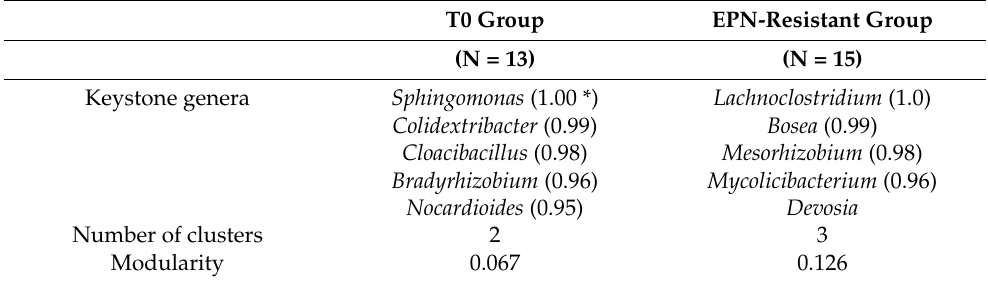
Table 3. Basic characteristics of microbiome networks in the T0 group of A. solstitiale larvae and EPN ‐ resistant larvae.